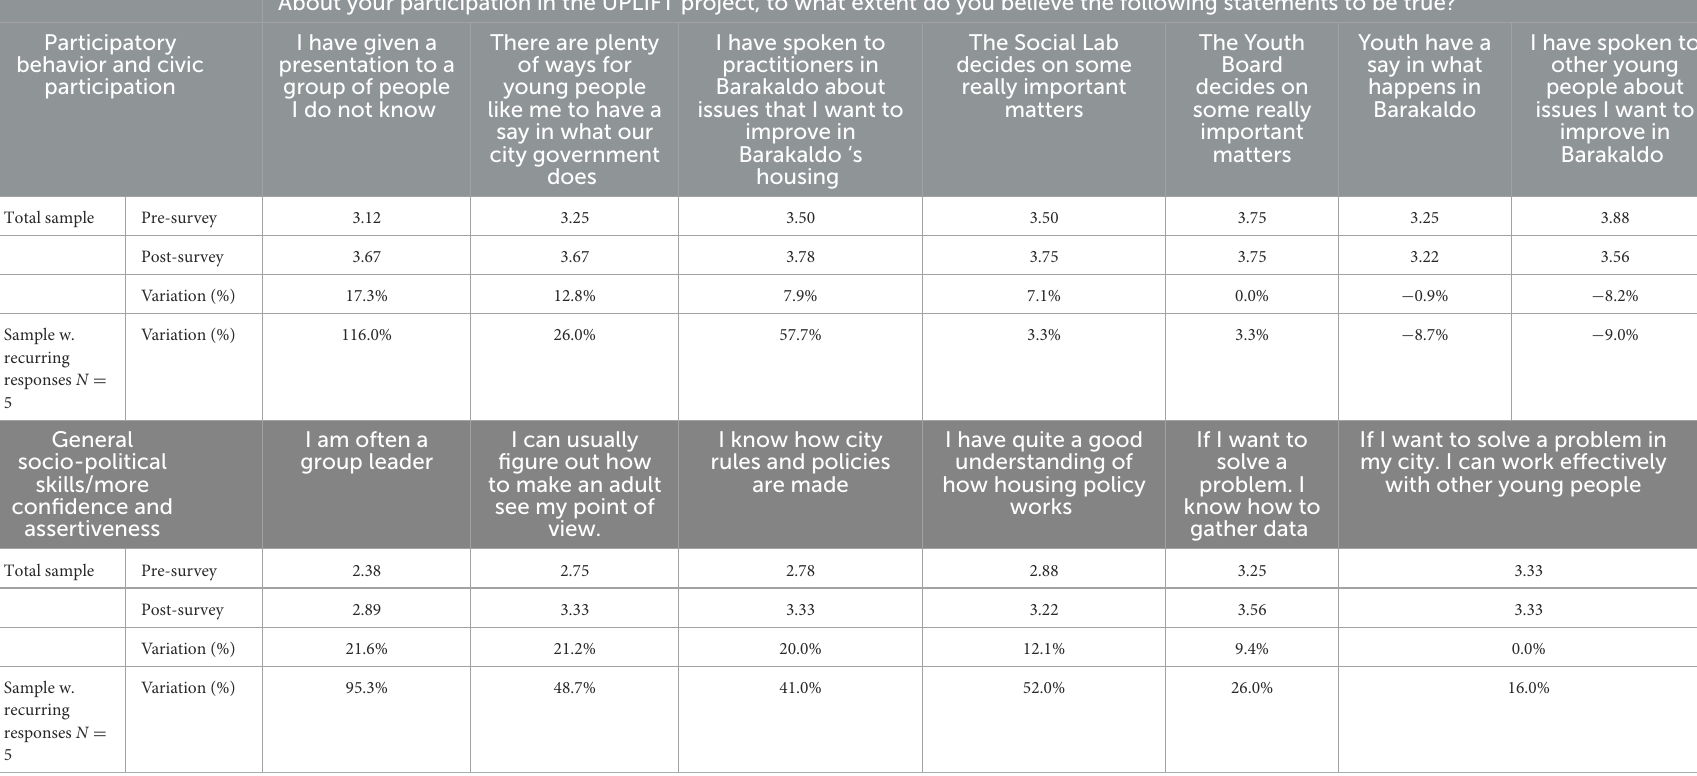
TABLE 4 How participating in UPLIFT affected the young individuals’ attitudes and behaviors (participatory behavior and socio-political skills). About your participation in the UPLIFT project, to what extent do you believe the following statements to be